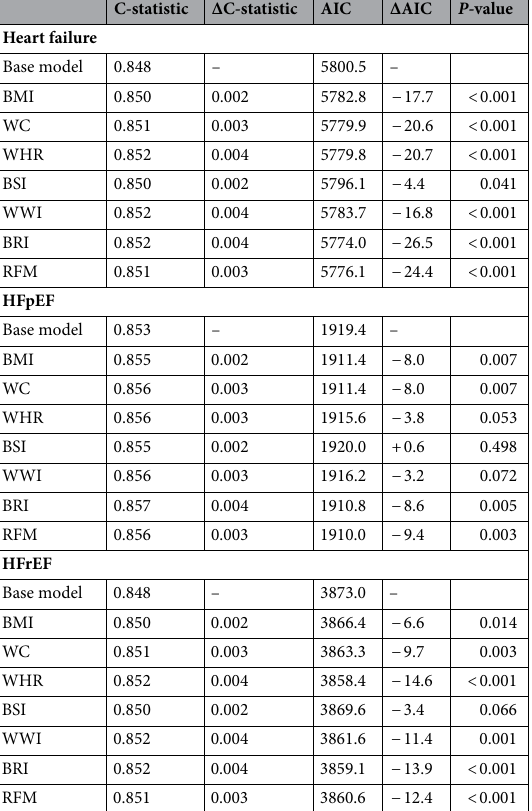
Table 5. Adiposity indices and improvement in model fit. AIC represents Akaike information criterion. All other abbreviations are same as in Table 2. P-values are based on likelihood ratio test. If the reduction in AIC is less than 2: no substantial evidence to support the candidate model; between 4 and 7: candidate model has considerably less support; greater than 10: no support for the candidate